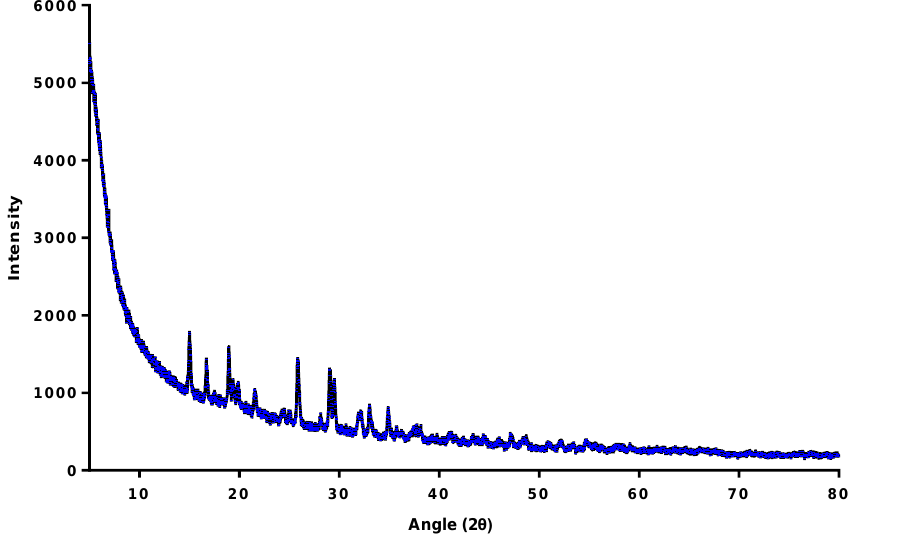
Figure 5. Scanning micrograph of the bioflocculant ( a ), kaolin particles ( b ), and flocculated kaolin particles ( c ). 3.5. Flocculation Properties of the Purified Bioflocculant 3.5.1. Dosage Size Effect on Flocculating Activity In deciding bioflocculant efficiency, dosage concentration is a critical factor. Inade- quate or excessive dosage can lead to inhibition in bioflocculant performance. Moreover, appropriate dosage sizes minimize expenses [64]. Thus, the effect of the dosage size was evaluated. The flocculating activity of the bioflocculant initially increased with the in- crease in dosage size; a subsequent decrease in activity was observed at dosage sizes